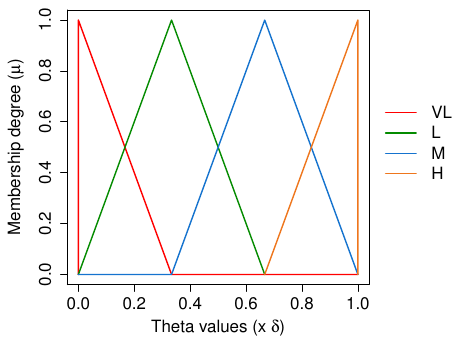
Figure 6. Fuzzy output membership functions.